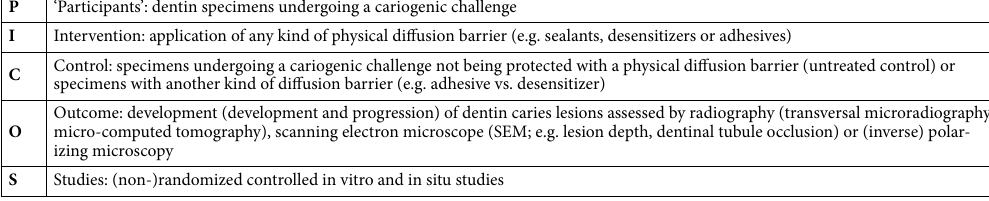
Table 1. PICOS schema: Population (P), Intervention (I), Comparison (C), Outcomes (O) and Study Design